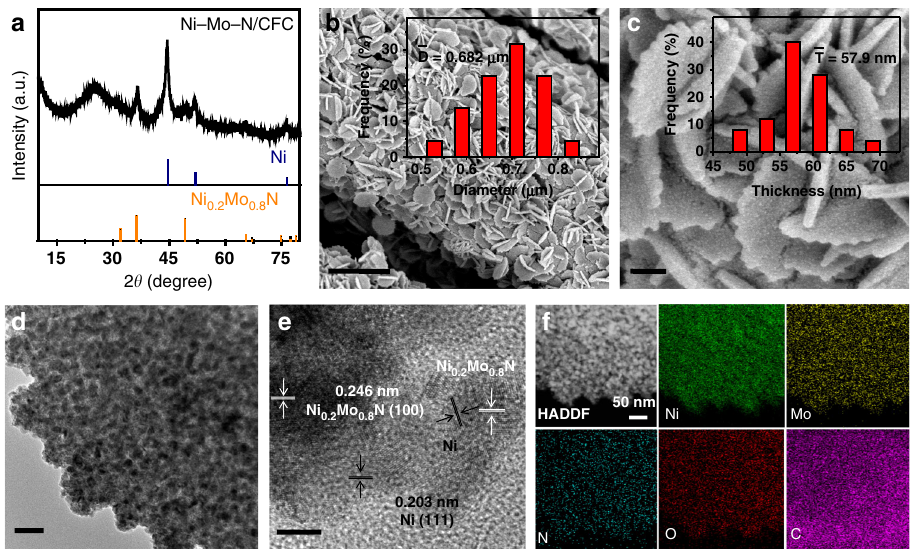
Fig. 1 Structural and morphological characterizations of Ni – Mo – N/CFC. a XRD pattern, b , c SEM, d TEM, e HRTEM images, and f STEM-EDX mapping of Ni – Mo – N/CFC. The inset images in b and c are the diameter (left) and thickness (right) distributions of Ni – Mo – N/CFC nanoplates. Scale bars, b 2 µ m; c 200 nm; d 50 nm; e 5 nm, f 50